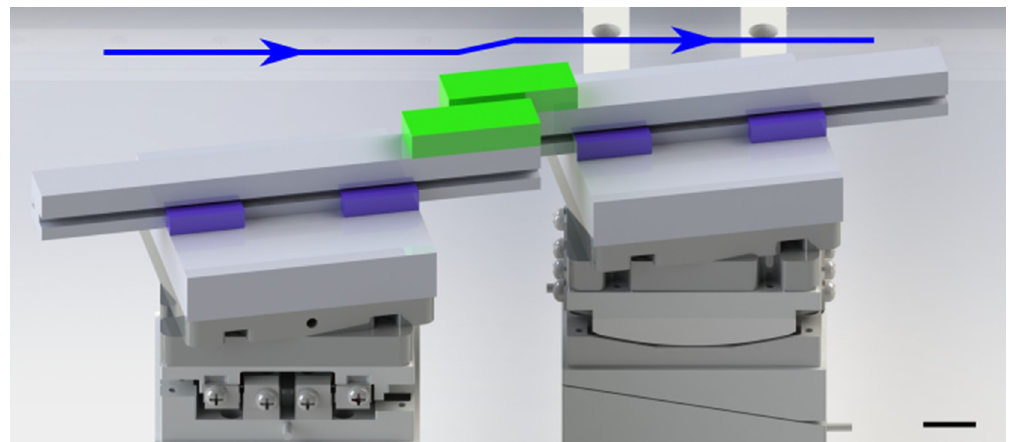
Figure 4. Illustrative mechanical layout of the C1 and C2 stages in the state of minimum surface distance. Green blocks illustrate the effective parts of the crystals. The blue lines above illustrate the beam path. The SMARACT Modular System is used for illustration. The black scale bar denotes 10 mm.